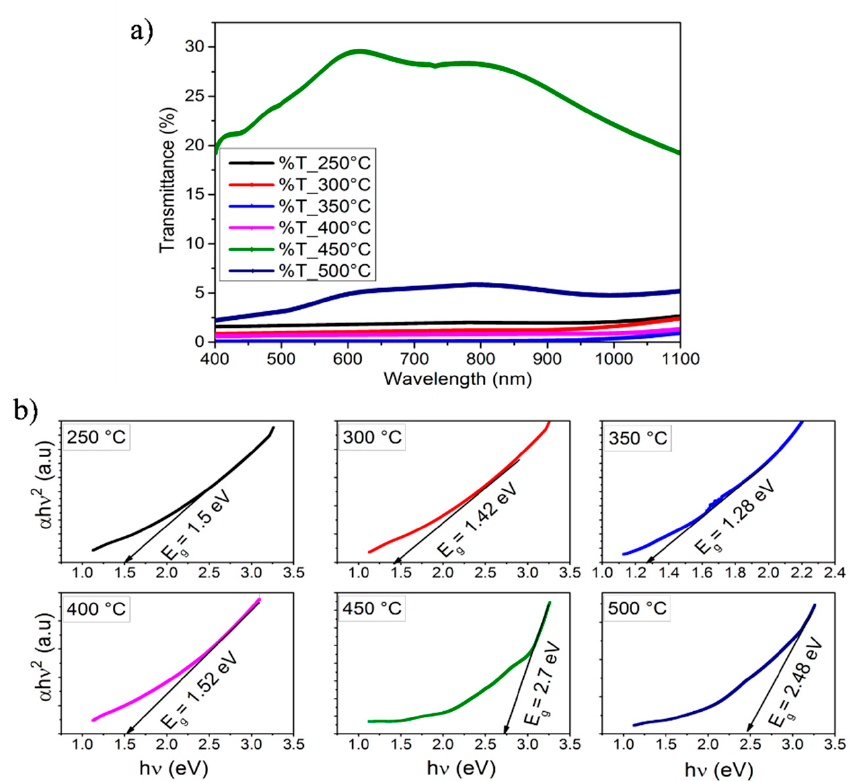
Figure 6. Transmittance spectra ( a ) and Tauc’s plots ( b ) for direct band gap determination of the CuSbSe 2 thin films annealed at different temperature.